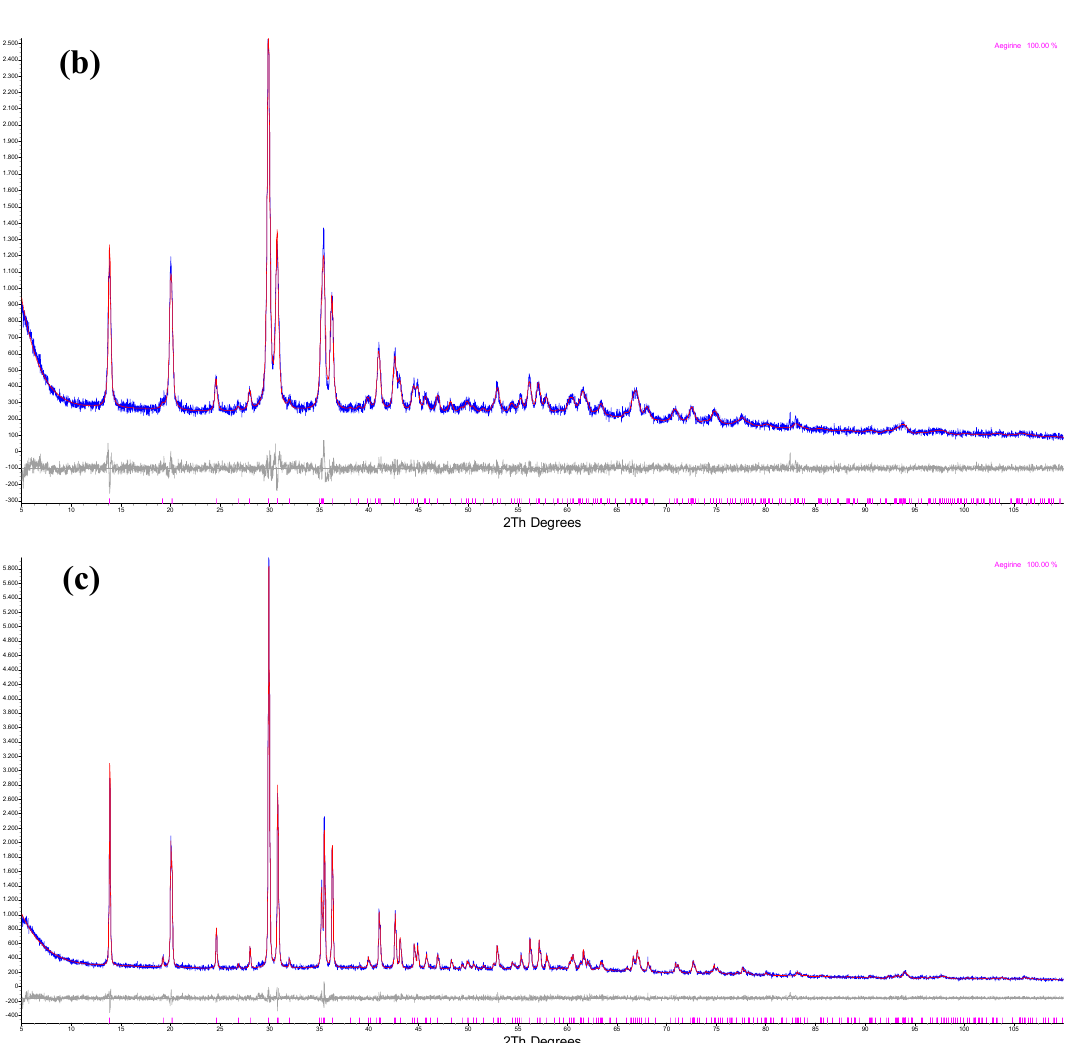
Figure A2. Typical Rietveld refinement plots as obtained from the final refinements of samples, synthesized at ( a ) 160 °C and ( b ) 230 °C for 24 h and ( c ) at 200 °C and annealed at 900 °C for additional 24 h.